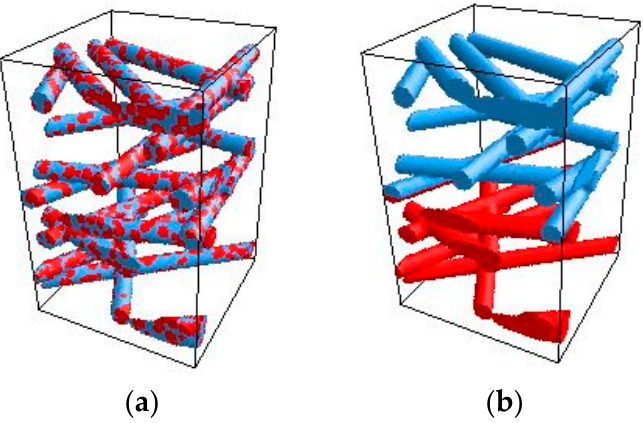
Figure 5. Applied cases of charge distribution on fibers: ( a ) random distribution of spherical charge spots on an oppositely charged background, ( b ) dividing the complete fibrous structure in two parts with opposite polarity (according to [13]).